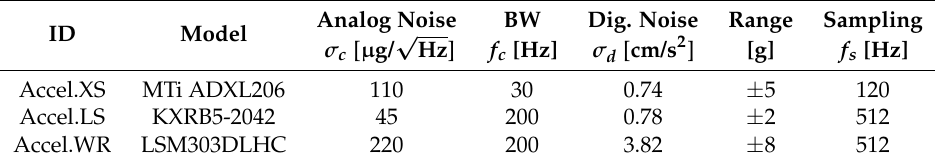
Figure 2. ( Left ) End effector designed to test several sensor units at once. ( Right ) Robot tool motion and sensor attachment. Table 3. Accelerometer characteristics from their